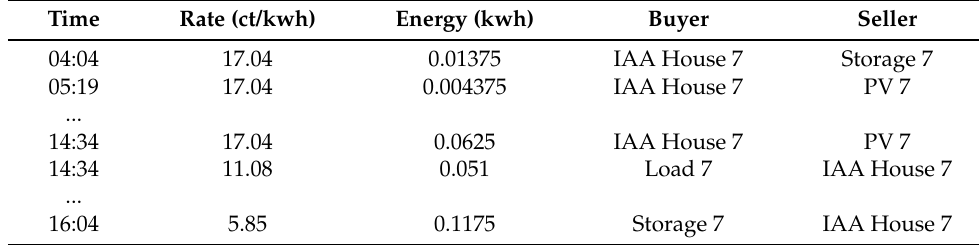
Table 5. House 7 internal trades for April